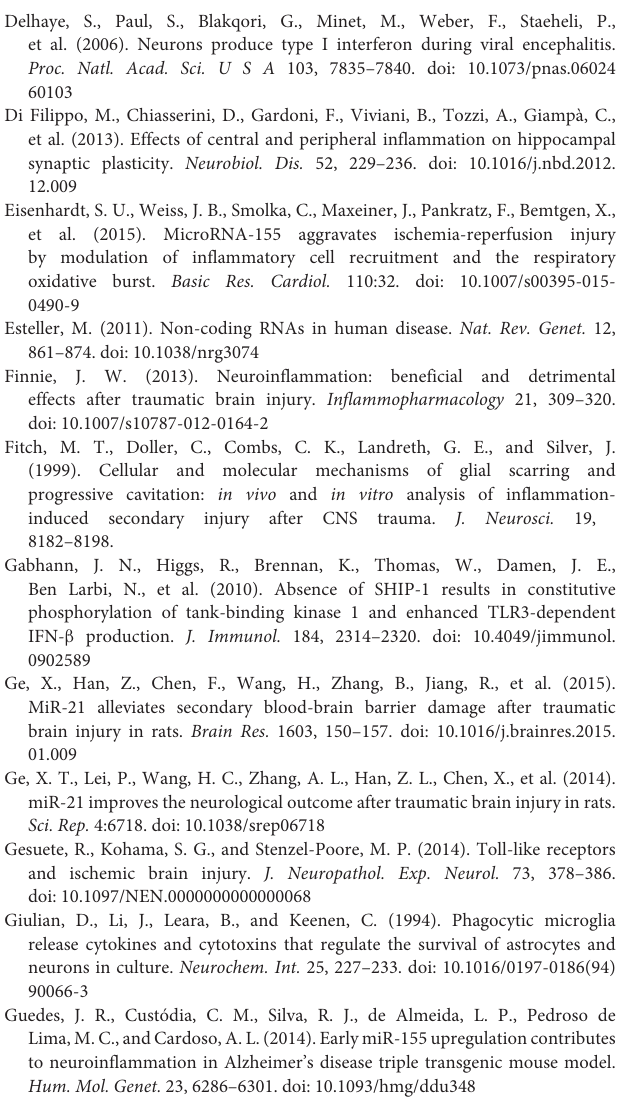
FIGURE S1 | Nuclear, neuronal localization of miR-155 in the cortex after controlled cortical impact (CCI). (A) Fluorescence in situ hybridization (FISH) for miR-155 1, 3 and 7 days after moderate CCI and in naïve mice. Images show the injury lesion boundary in the cortex. (B) FISH and Co-IHC was performed for neuronal marker MAP2 (green), nuclei (blue), miR-155 (magenta). Scale bars = 50 µ